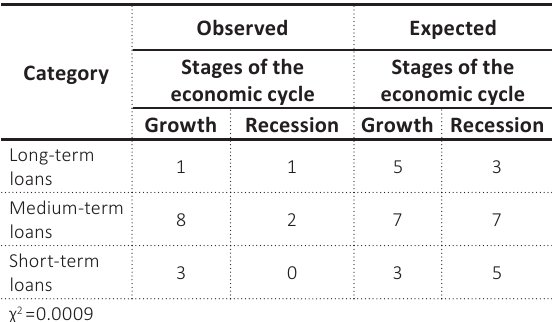
Table 2. Pilot testing parameters of the chi-